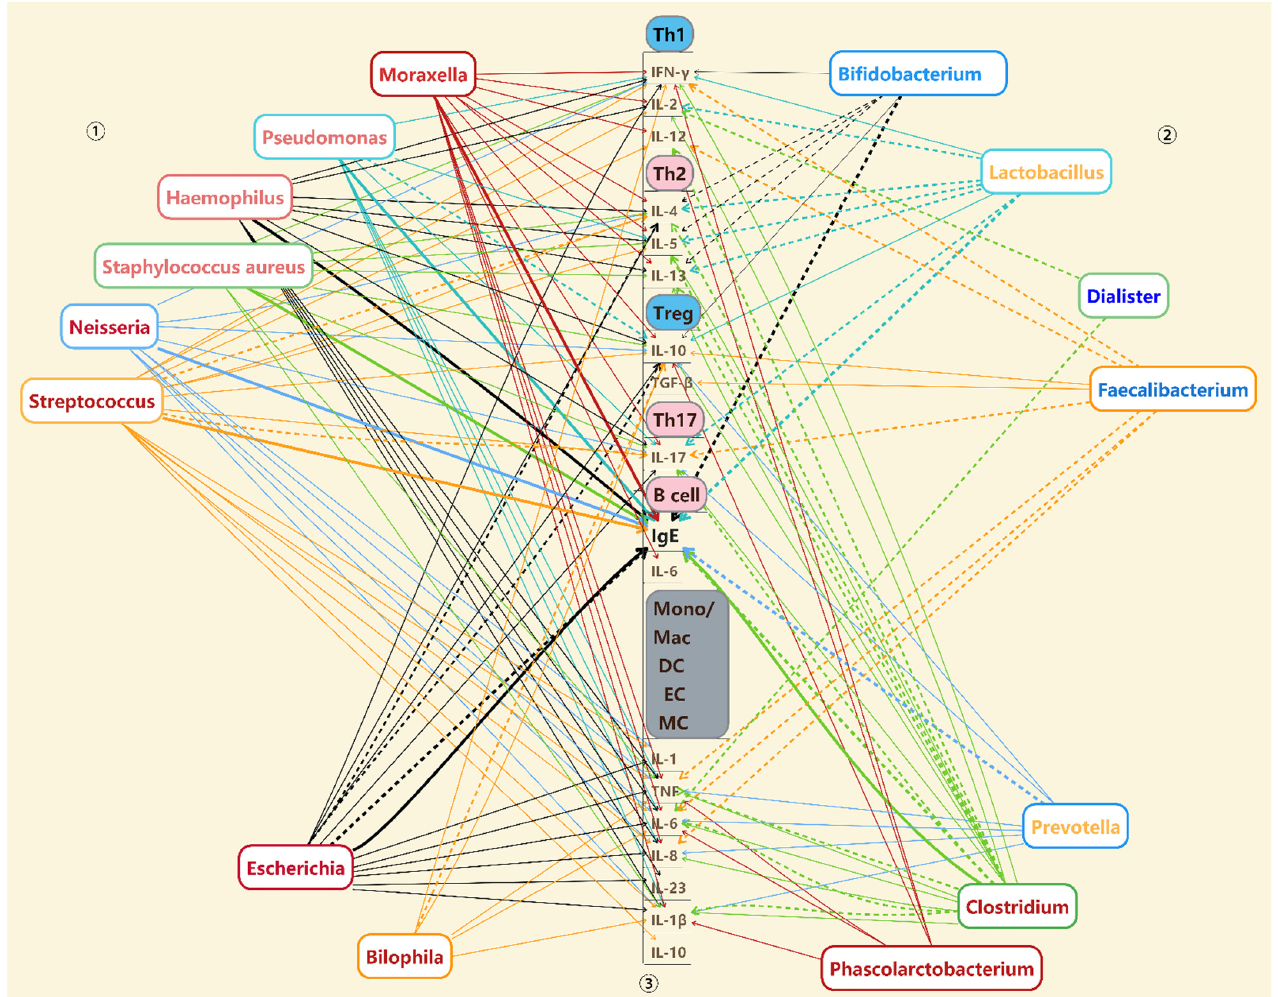
Figure 3. The relationship between co-changing bacteria and immune disturbances. ① Bacteria that promote immune inflammation and are positively correlated with IgE. ② Bacteria with anti- inflammatory effect. ③ Bacteria with some positive correlation with immune inflammation, but whose relationship with IgE is unclear. Emphasized relationships are in bold. Solid lines represent positive correlations and dashed lines represent negative correlations. Red words represent the in- creased prevalence of bacteria in at least two diseases at the same site, pink words represent the predominantly increased prevalence of the bacteria in two diseases at the same site, blue words represent the decreased prevalence of the bacteria in at least two diseases at the same site, light blue words represent the predominantly decreased prevalence of bacteria in two diseases at the same site, and yellow words represent the change in the same bacteria in different diseases which cannot be determined. Mono/Mac: monocytes/macrophages. MC: mast cells, EC: epithelial cells, DC: den- dritic cells.